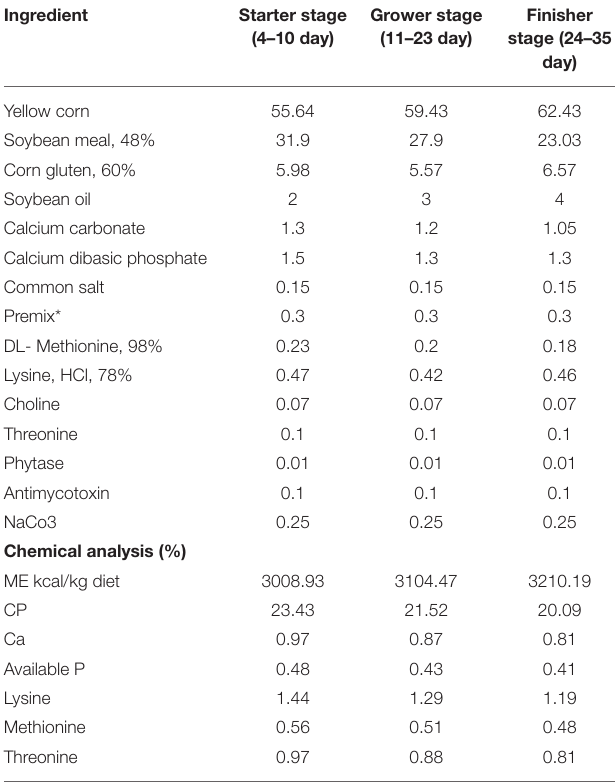
TABLE 1 | Proximate and chemical composition of the basal diets